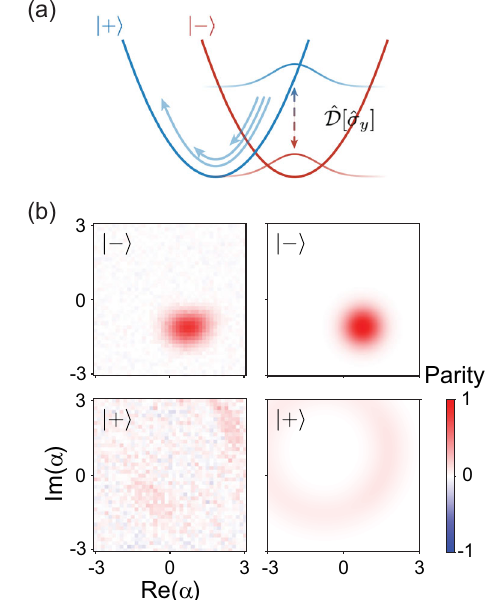
FIG. 3. Wave-packet branching under white noise dephasing. (a) A ground state reactive wave packet j − i ⊗ j α branches from g i the red potential surface to the blue potential surface when a dephasing event flips the electronic qubit from j − i to jþi (and vice versa). When the wave packet branches at random times, it will subsequently evolve along the blue potential surface which diffuses the oscillator state toward a mixed state. (b) Measured (left) and simulated (right) Wigner functions of the tuning mode conditioned on the ˆ σ measurement outcome being either j − i x (top, P − ¼ 91% ) or jþi (bottom, P ¼ 9% ) after evolving þ parameters listed in the main text. Experimentally, the overall phase of the measured Wigner functions is determined by the phase acquired by the cavity relative to the initial displacement due to Stark shifts and is free to be adjusted [40]. The phase in the simulation is aligned to that of the coherent projected data ( j − i ). Additional deviations of the experimental data from the simu- lation are likely due to higher order Hamiltonian terms, whose precise calibration and control remain an open task left for future